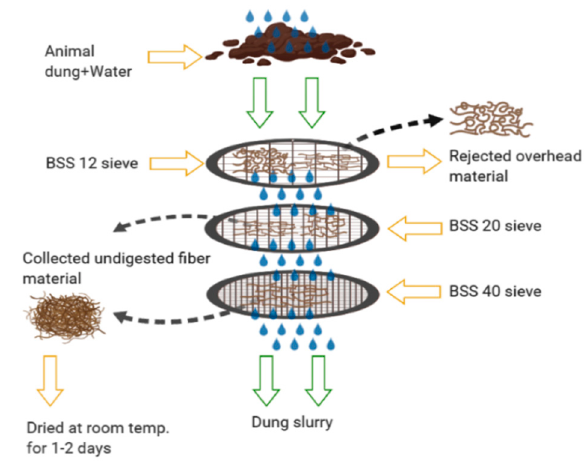
Figure 1. Schematic view of separation of undigested dung material and dung slurry.